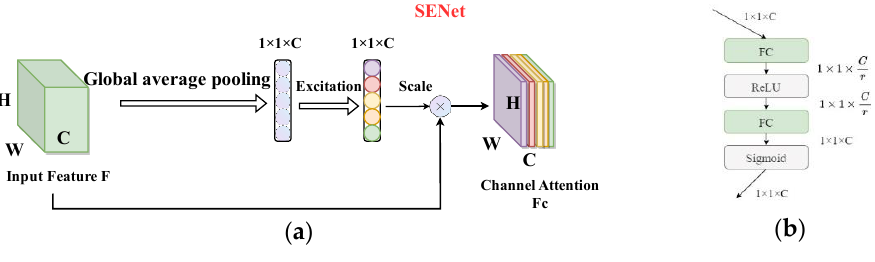
Figure 9. ( a ) SENet ( b ) the process of Excitation.